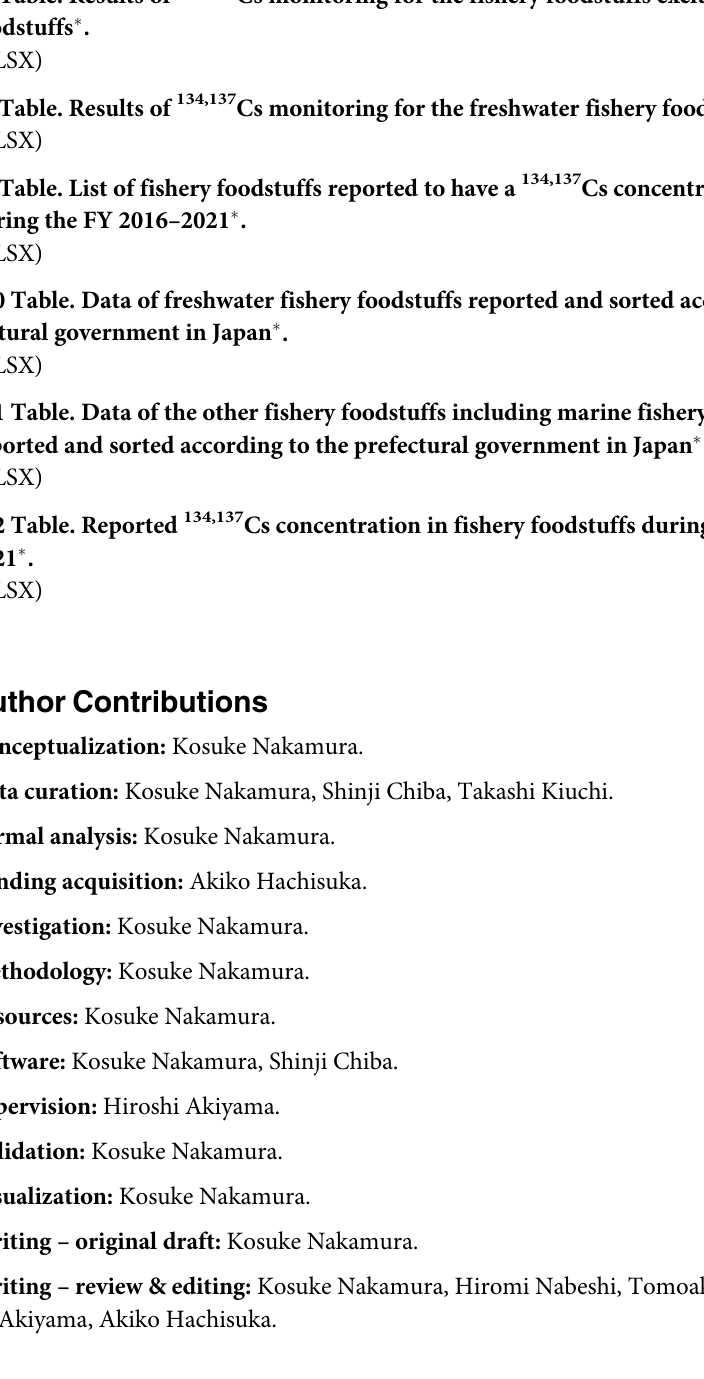
S5 Table. Summary of 134,137 Cs concentration in foodstuffs reported during the FY 2012– 2021 � . S6 Table. List of the foodstuffs in the “general foodstuffs” category reported to exceed the JML (100 Bq/kg). S7 Table. Results of 134,137 Cs monitoring for the fishery foodstuffs excluding freshwater foodstuffs � . S8 Table. Results of 134,137 Cs monitoring for the freshwater fishery foodstuffs � . (XLSX) S9 Table. List of fishery foodstuffs reported to have a 134,137 Cs concentration > 25 Bq/kg during the FY 2016–2021 � . S10 Table. Data of freshwater fishery foodstuffs reported and sorted according to the pre- fectural government in Japan � . S11 Table. Data of the other fishery foodstuffs including marine fishery foodstuffs reported and sorted according to the prefectural government in Japan � . S12 Table. Reported 134,137 Cs concentration in fishery foodstuffs during the FY 2016– 2021 �